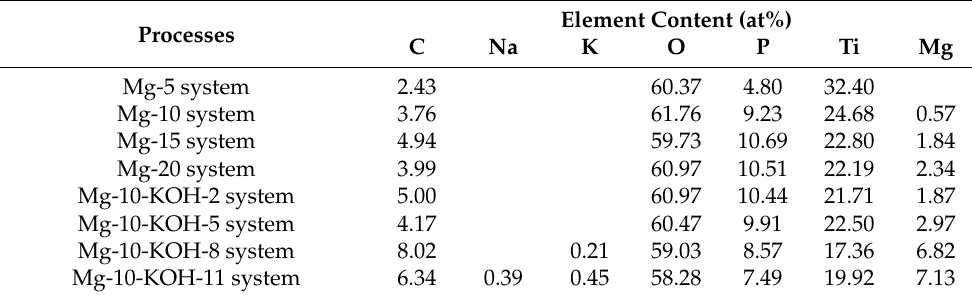
Table 2. Chemical composition of MAO coatings obtained in solutions composed of 15-g/L H 12 Phy and various concentrations (5, 10, 15 and 20 g/L) of Na 2 MgY, and the S-Mg-10 system was added with 2, 5, 8 and 11-g/L KOH.